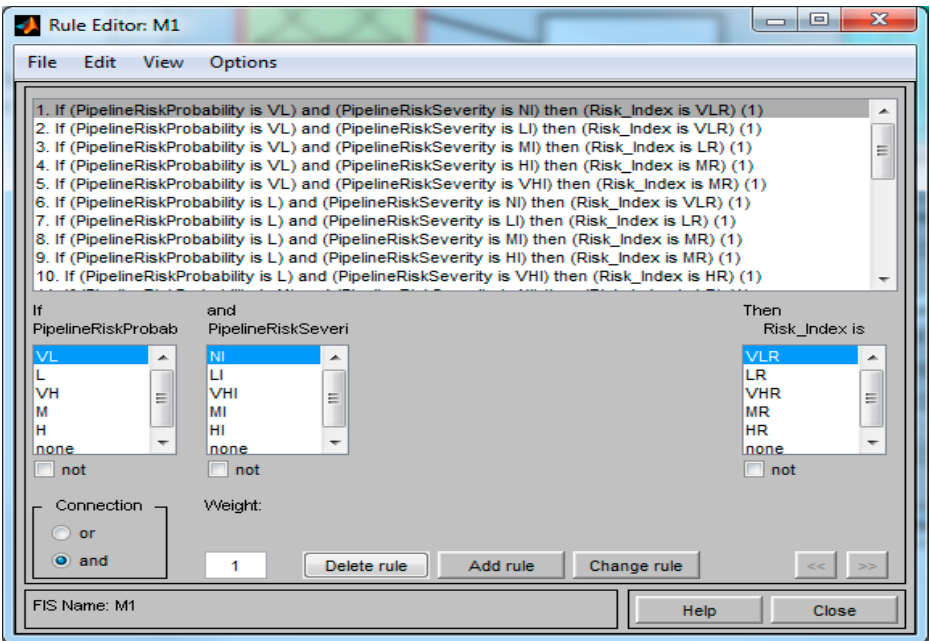
Figure 9. Rule editor for specifying average rule-based method rules.